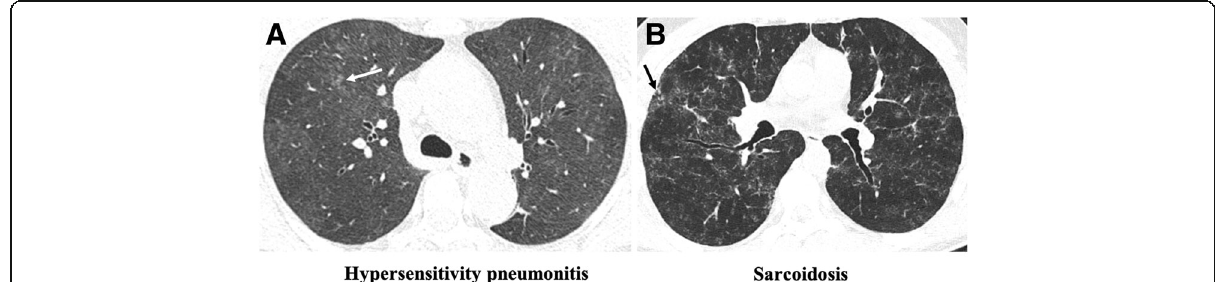
Fig. 17 Differential diagnosis of RB-ILD. a Axial CT image depicts subacute hypersensitivity pneumonitis (HP) in a 71-year-old woman with a long history of exposition to moldy hay (farmer ’ s lung). Imaging findings of HP are similar to RB-ILD, which also appears as centrilobular nodules predominantly in the upper lobes (arrow) and patchy areas of ground-glass attenuation. A clinical history is crucial to make the differential